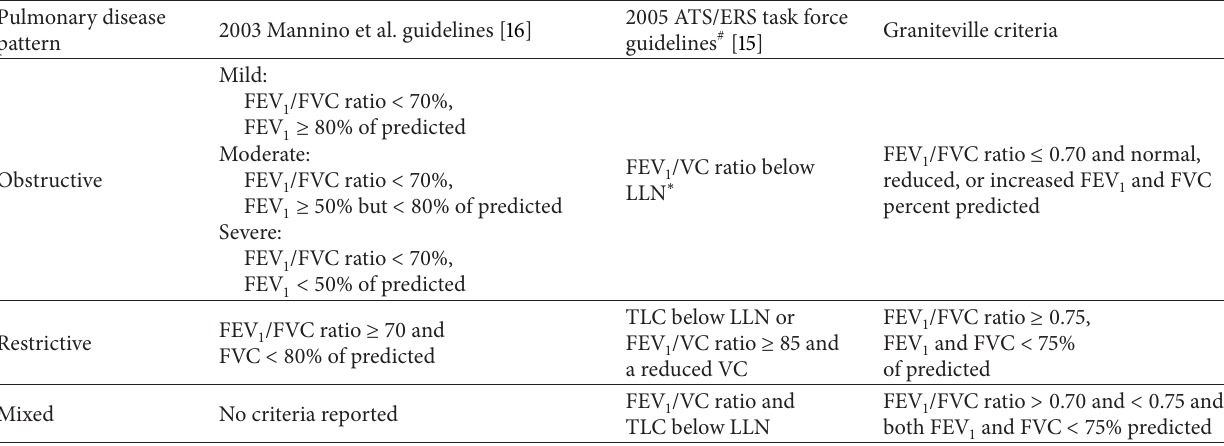
Table 1: Comparison of different criteria for classification of pulmonary disease patterns.